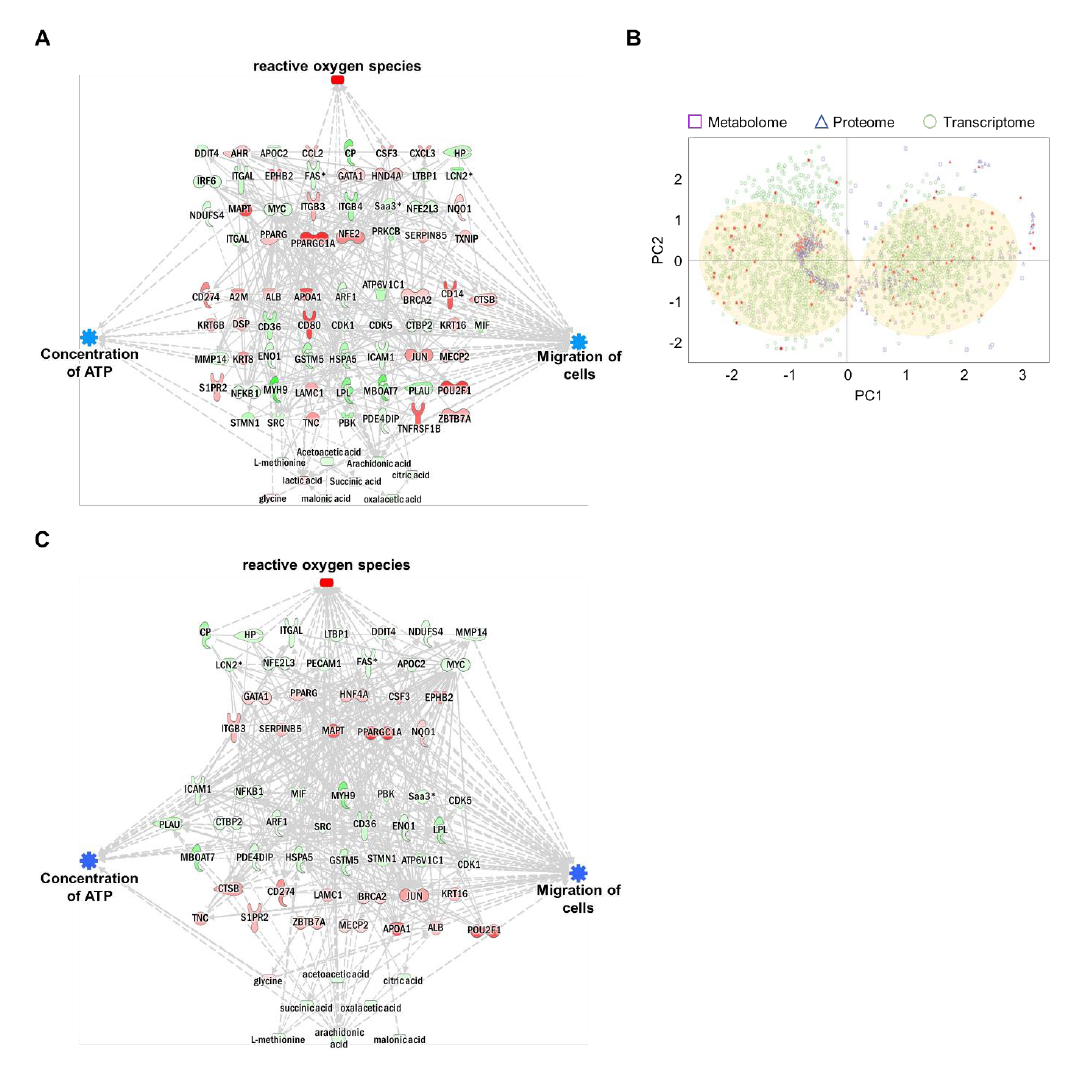
Figure 5. Construction of an integrated triple-omics network in MNPs@SiO 2 (RITC)-treated BV2 cells. ( A ) The merged and trimmed triple-omics network of 0.1 µg/µL MNPs@SiO 2 (RITC)-treated BV2 cells with the prediction. Top group: transcriptome, middle group: proteome, bottom group: metabolome. Orange and blue areas indicate prediction as activation and inhibition, respectively. Downregulated Fas, Lcn2, Saa3, and Mmp14 expressions were shared between the transcriptome and proteome. Symbols are described in the legend of Figure S2. ( B ) PCA for triple-omics factors. Filled spots indicate items included in the simply merged triple-omics network. The translucent yellow circle indicates the location of the major dominant cluster. ( C ) The trimmed network using the machine learning algorithm and integrated prediction network for four categories of biological functions of omics data derived from 0.1 µ g/ µ L MNPs@SiO 2 (RITC)-treated BV2